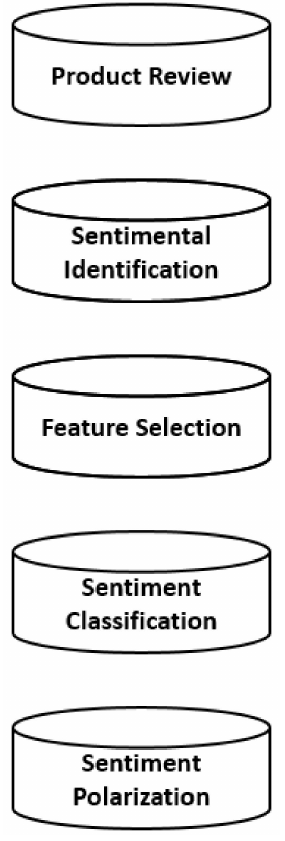
Figure 3. Layer based Study